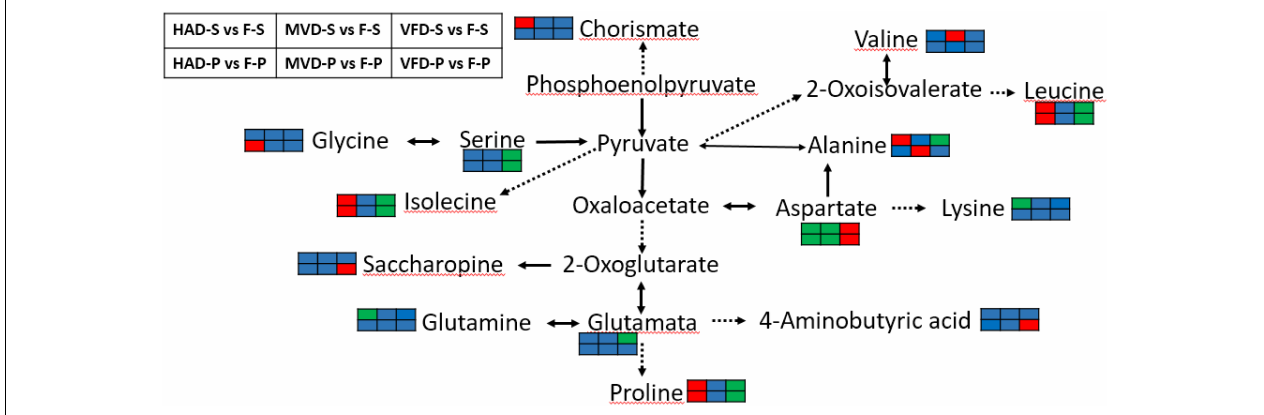
FIGURE 7 | Biosynthesis of amino acids. (The red color rectangle indicates that the metabolite content is significantly up-regulated; the green rectangle indicates that the metabolite content is significantly down-regulated; the blue rectangle indicates no significant difference in that metabolite